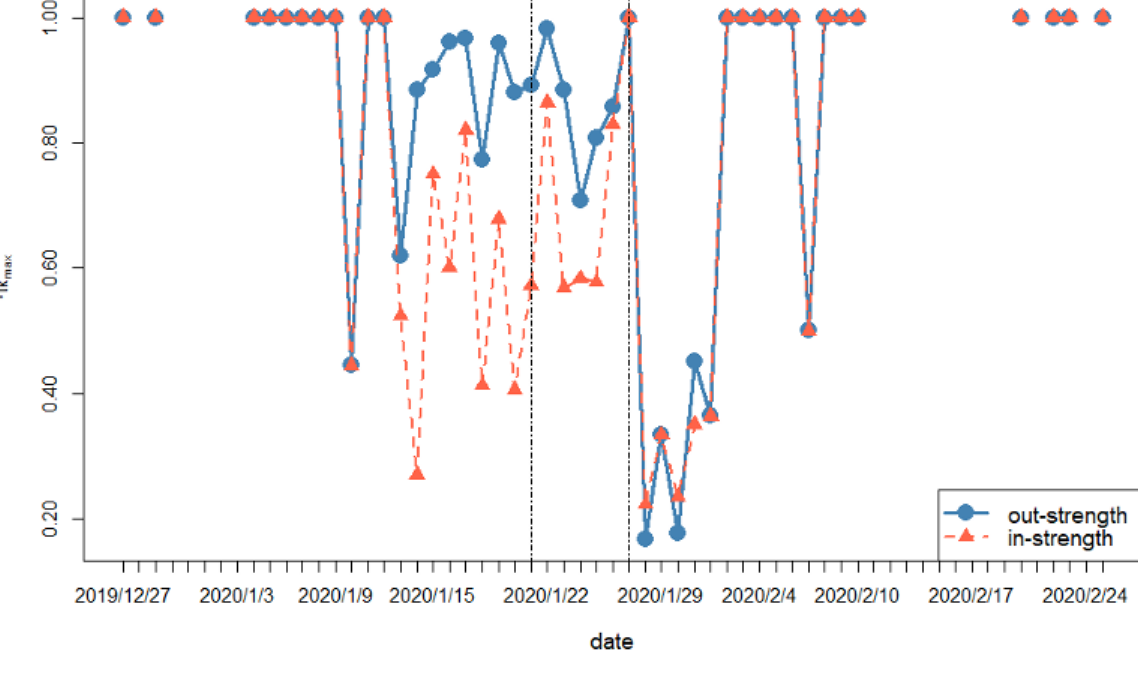
Figure 11. Daily evolution of the innermost shell from the perspectives of out-strength and in-strength in the COVID-19 epidemic network. The vertical dotted lines correspond to January 21, 2020, and January 27, 2020,